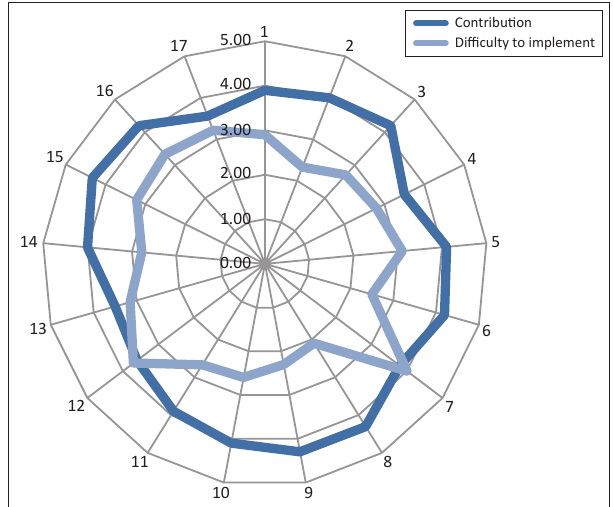
FIGURE 2: Contribution and/or difficulty implementing practices to overcome customer-related problems.